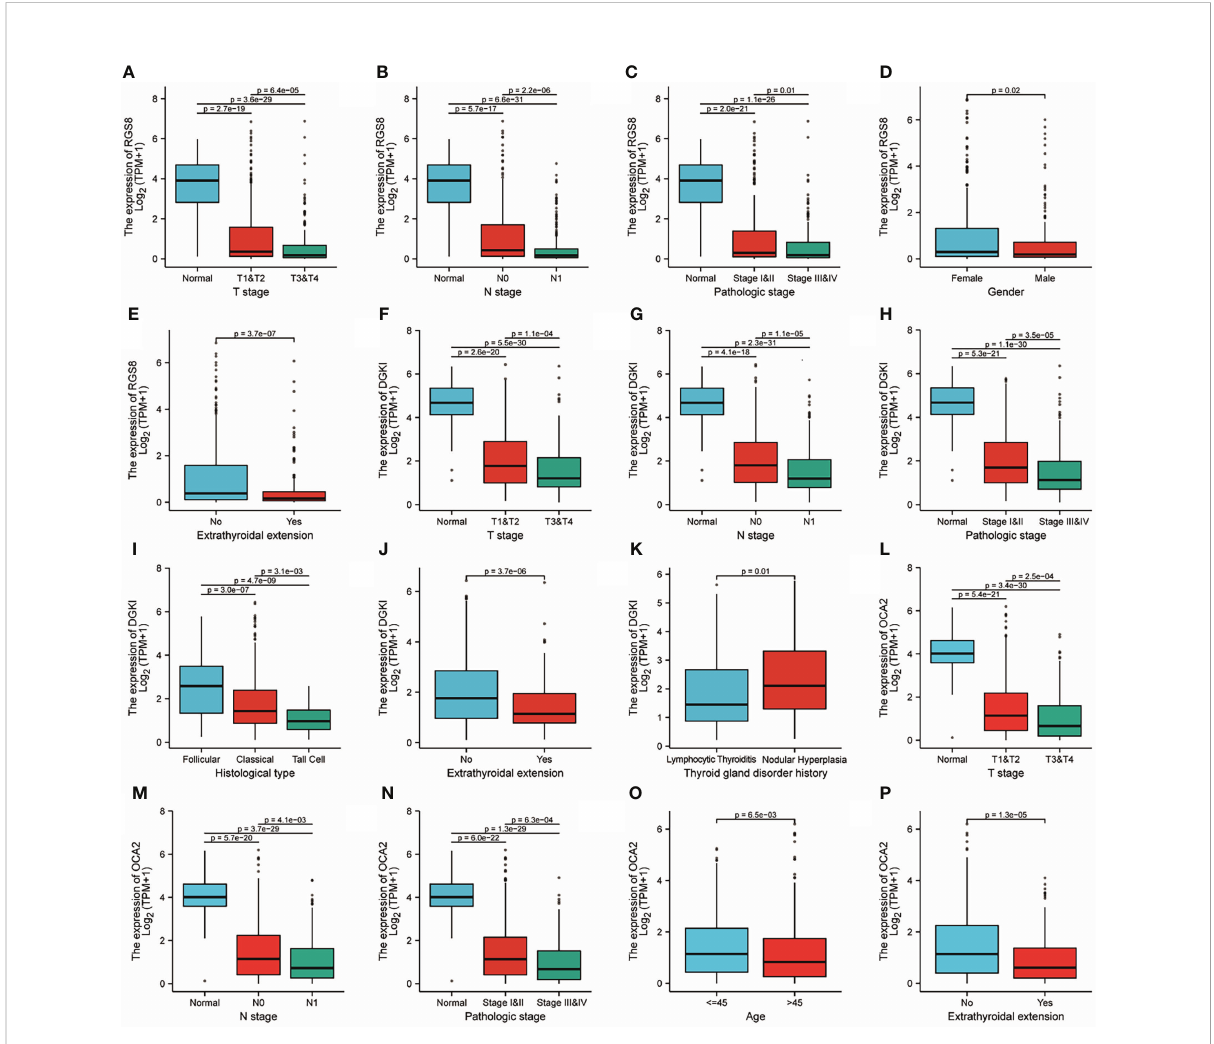
FIGURE 3 Clinicopathological features and expression of RGS8, DGKI and OCA2 in THCA. RGS8 expression level with T stage (A) , N stage (B) , pathological stage (C) , gender (D) , extrathyroidal extension (E) . DGKI expression level with T stage (F) , N stage (G) , pathological stage (H) , histological type (I) , extrathyroidal extension (J) , thyroid gland disorder history (K) . OCA2 expression level with T stage (L) , N stage (M) , pathological stage (N) , age (O) , extrathyroidal extension (P)